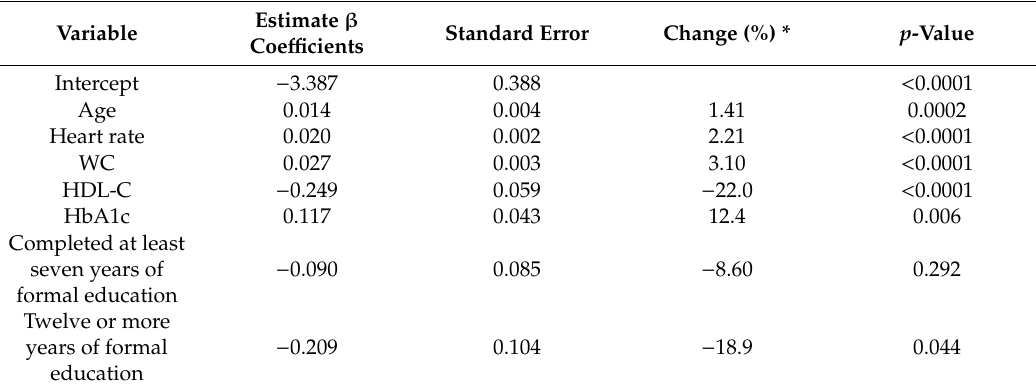
Table 4. Natural log-transformed CRP concentrations as a function of